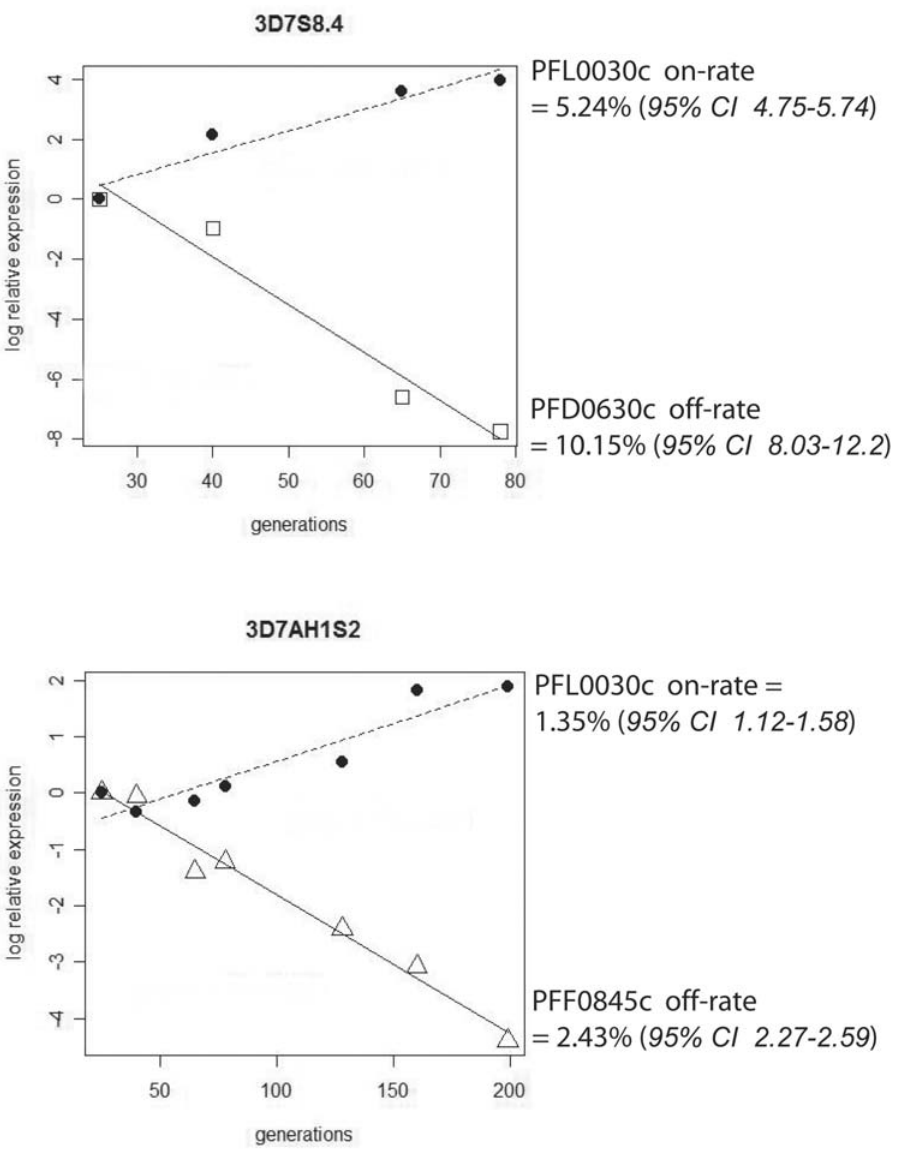
Figure 1. ‘‘On’’ and ‘‘Off’’ switching rate of dominant var and var2csa in 3D7S8.4 and 3D7AH1S2. Regression models were created by using the log of comparative expression level, log(2 DD Ct ) versus generations. In the case of 3D7S8.4, a linear range of regression was observed up to , 100 generations. Thus, the var on/off rates for 3D7S8.4 were determined up to 100 generations, whilst for the 3D7AH1S2, the estimations were made up to 200 generations, as the linear regression was maintained for a longer time period. The var on/off rates for 3D7S8.4 and 3D7AH1S2 were determined by the 2 2 DD Ct method, where DD Ct=(Ct var 2 Ct house-keeping ) t n 2 (Ct var 2 Ct house-keeping ) t 0 . The value for the first data collection ( t 0 ) was set as the baseline level (i.e. 15 and 25 generations for 3D7S8.4 and 3D7AH1S2, respectively.) The fold-change in the transcription compared to the baseline level was plotted, and the on/off rates of particular var- genes were estimated by the exponential function of the slope of the regression.